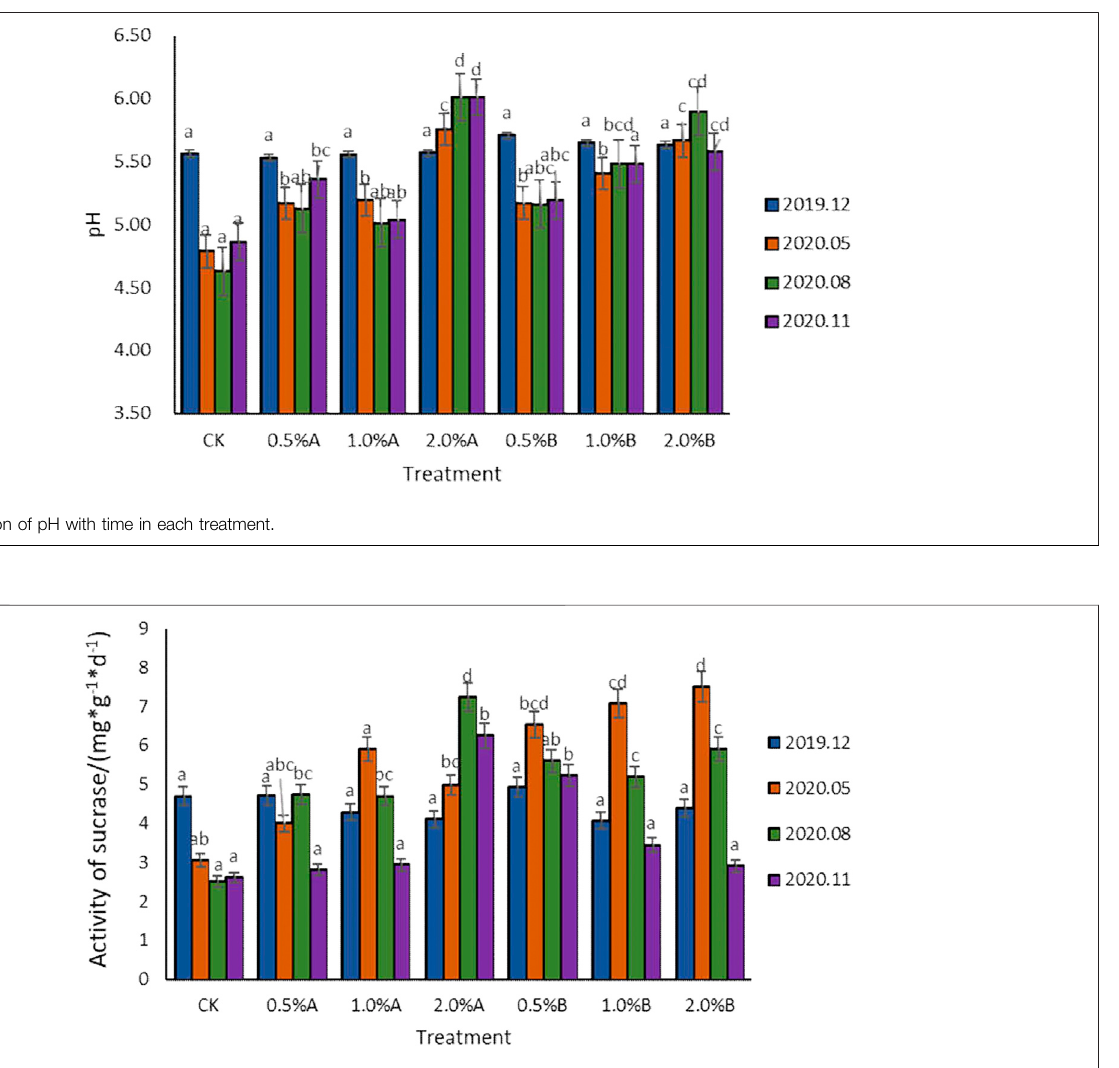
FIGURE 3 | Variation of sucrase activity with time in each